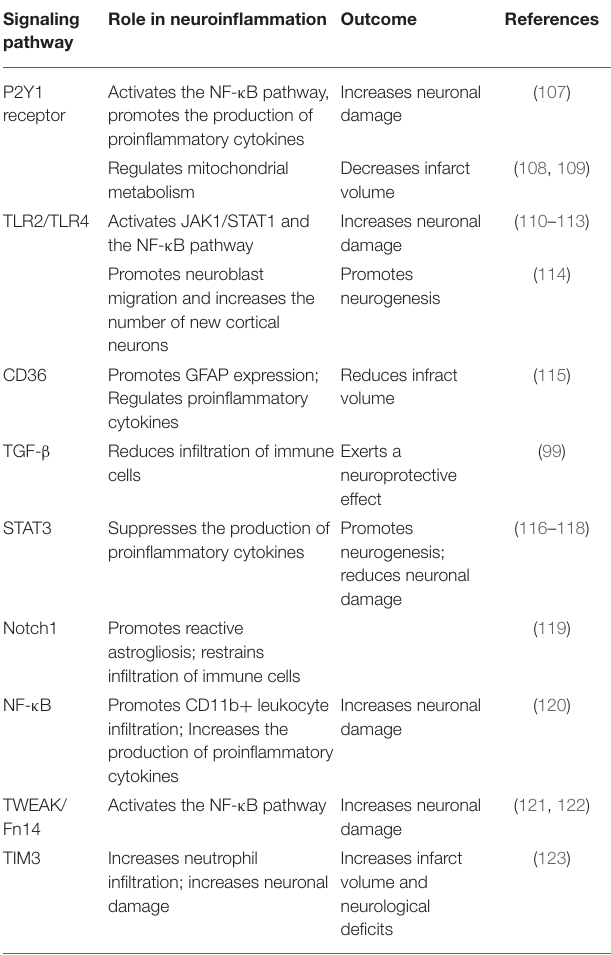
TABLE 1 | Astrocyte signaling pathways in post-stroke: innate immune